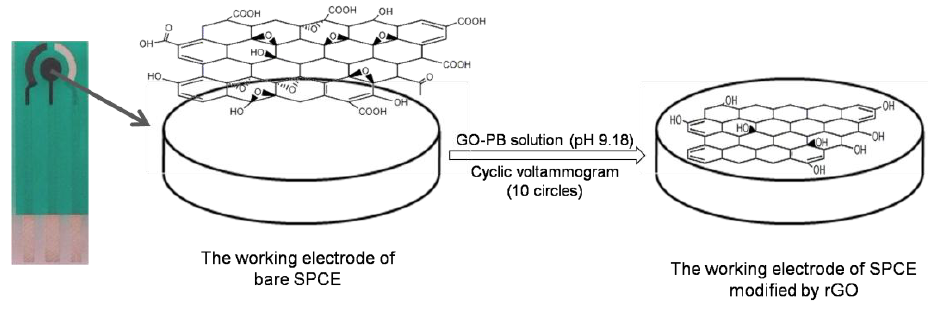
Figure 1. Schematic of electrochemical deposition of rGO on the surface of working electrode in the